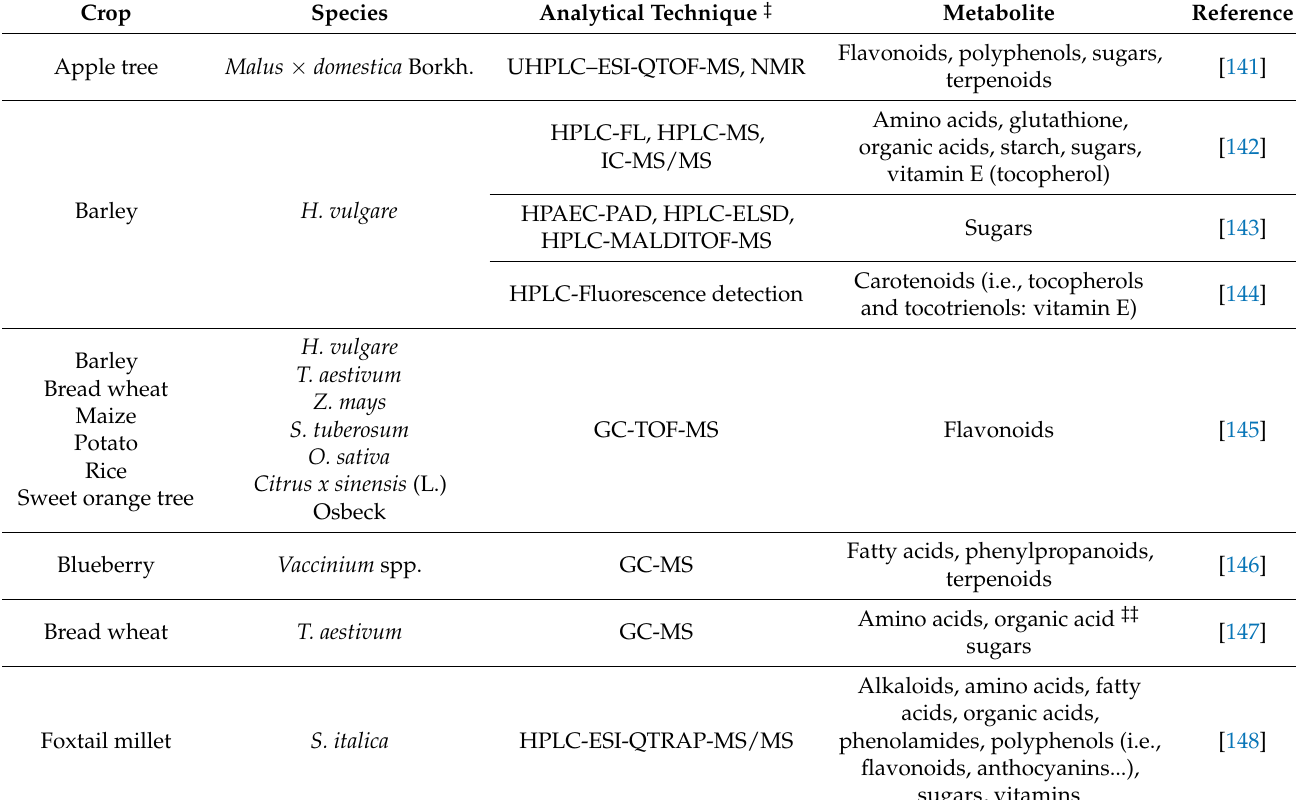
Table 2. Metabolomic genome-wide association studies (mGWAS). Only groups of compounds that play an important role in human nutrition and/or health status are